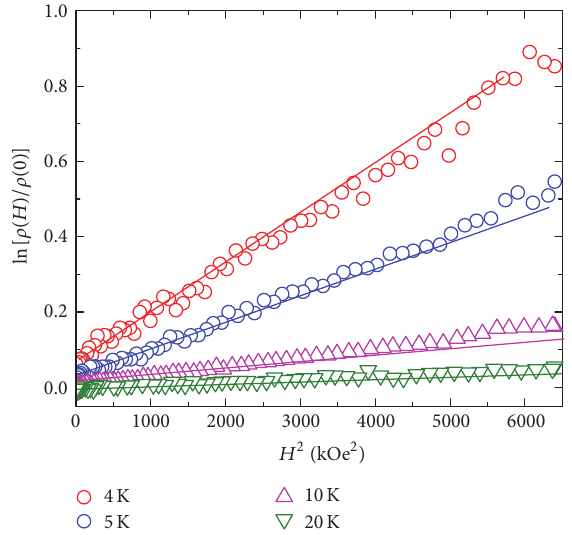
Figure 5: ln (𝜌(𝐻)/𝜌(0)) versus 𝐻 2 at different temperatures (sym- bols). Lines correspond to the results of the best linear fit in these coordinates.